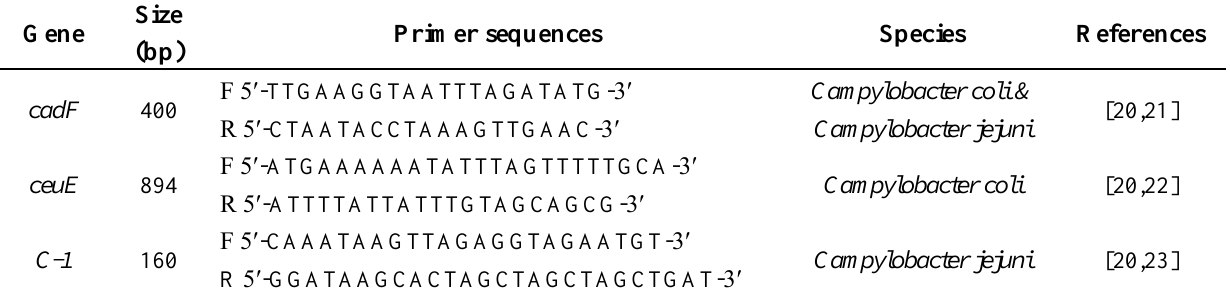
Table 1. A list of PCR primers used for Campylobacter jejuni and Campylobacter coli identification and their corresponding amplicon sizes and